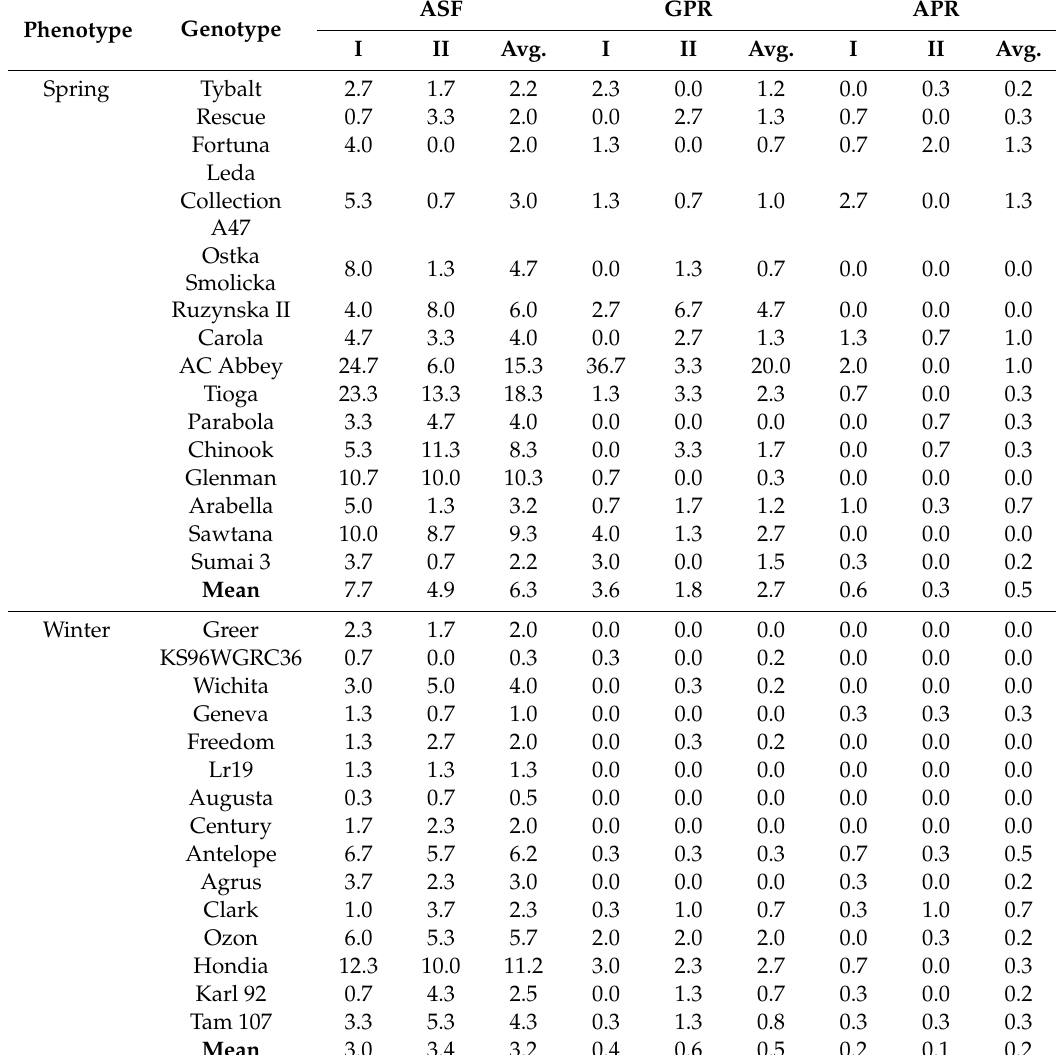
Table 1. The average e ffi ciency calculated for both tested media combinations of androgenic structures formation (ASF), green plants regeneration (GPR) and albino plants regeneration (APR) from the spring and winter wheat